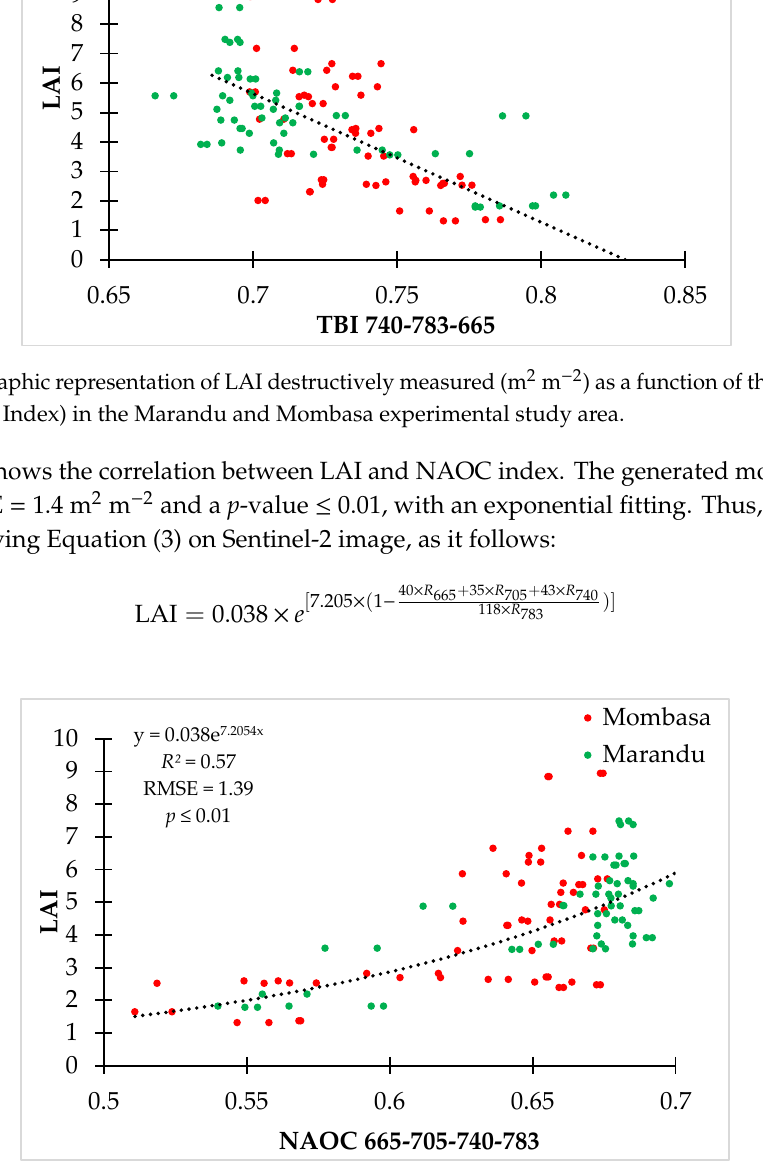
Figure 10. Graphic representation of destructively measured LAI (m 2 m −2 ) as a function of the NAOC vegetation index in the Marandu and Mombasa experimental study area.